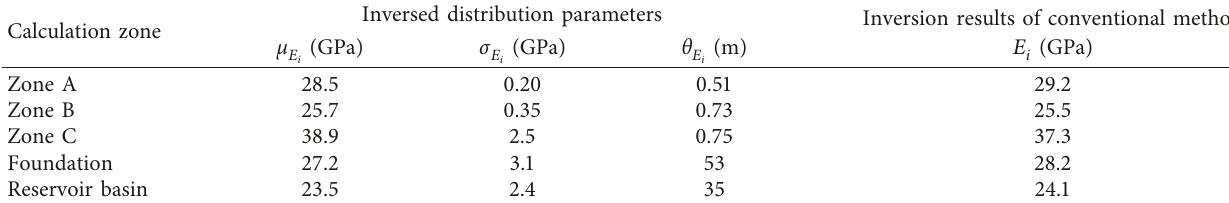
Table 4: Inversion results of different calculation zones and comparison with the conventional method.